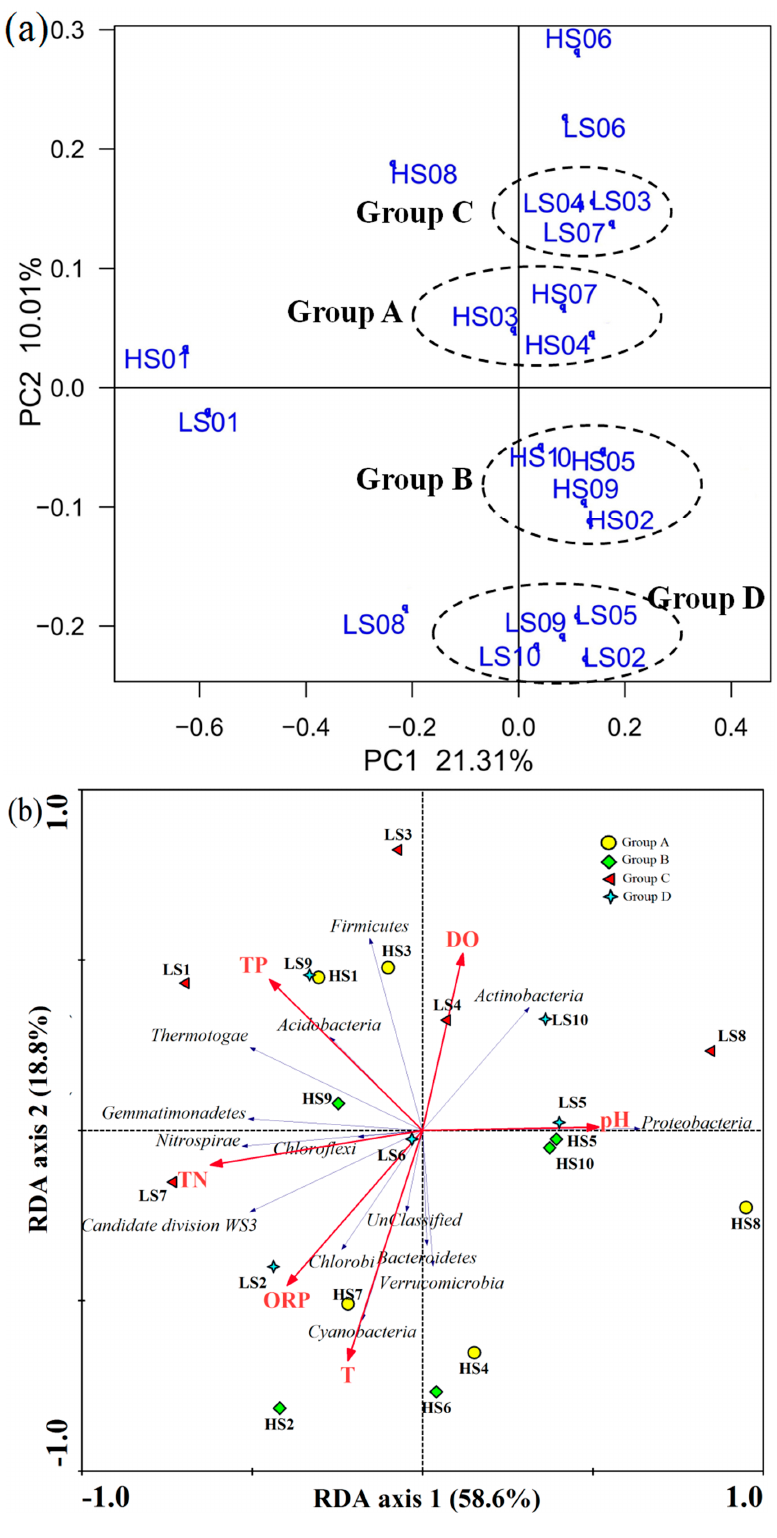
Figure 4. Ordination plot showing grouping of sediment samples according to their bacterial community structure ( a ); and the RDA ( b ) of the bacterial communities, as affected by environmental conditions, and based on the relative abundance of dominant bacterial phyla.